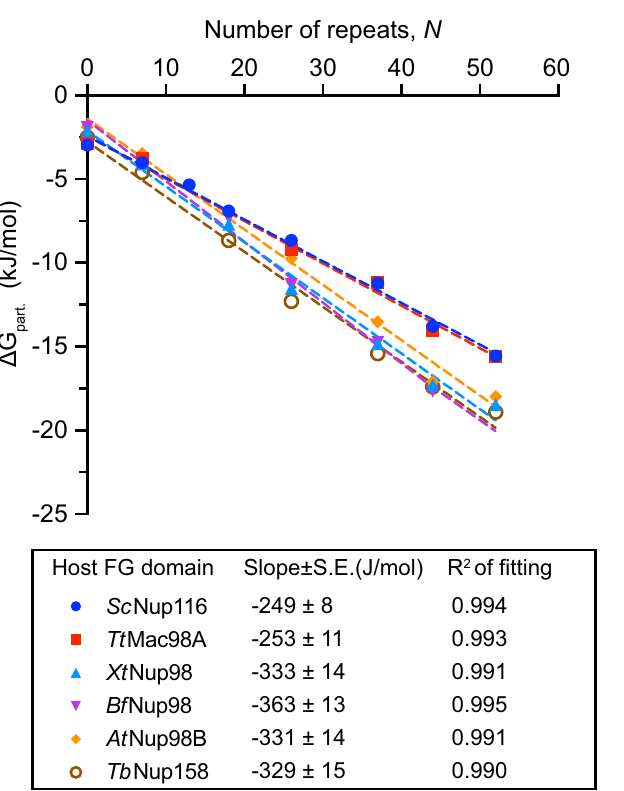
Fig. 2 | Energy contribution per FG repeat unit in partition into FG phases assembled from various species. Partition coef fi cients of the perfect repeat “ guests ” into different “ hosts ” , FG phases assembled from Nup98 FG domain homologues from different eukaryotic species ( Saccharomyces cerevisiae, Sc ; Tet- rahymena thermophila, Tt; Xenopus tropicalis, Xt; Branchiostoma fl oridae , Bf; Ara- bidopsisthaliana,At and Trypanosoma brucei,Tb ), were measured at150mM NaCl (data see Source Data fi le),and Δ G part . calculated by Eq.1 was plottedagainst N for different Nup98 FG domain homologues ( n =3, with independent samples, mean values are shown, S.D.s are smaller than the size of the symbols). Lower panel: ) are presented as best- fi t values±S.E. of fi Slopes of the plots ( d Δ G part : dN